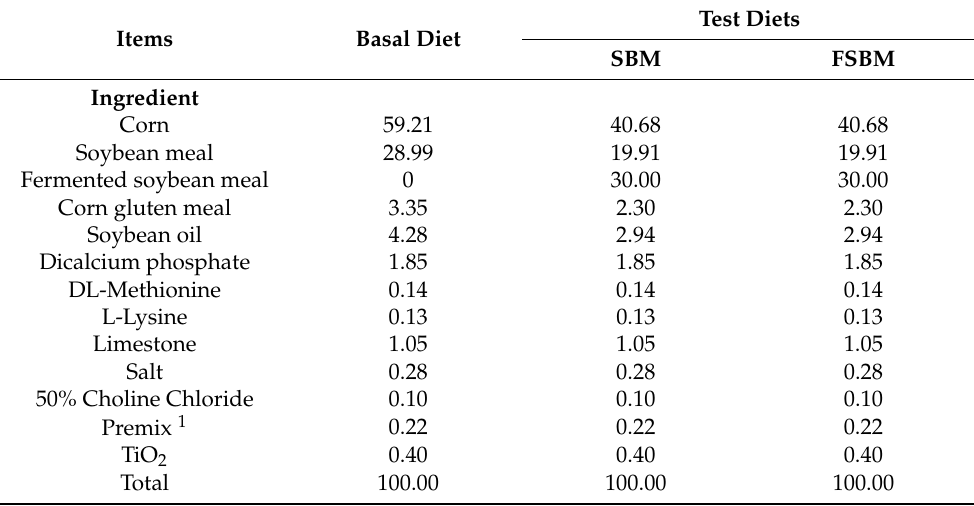
Table 1. Ingredient composition and nutrient levels of the basal diet and test diets (air-dry basis, %).